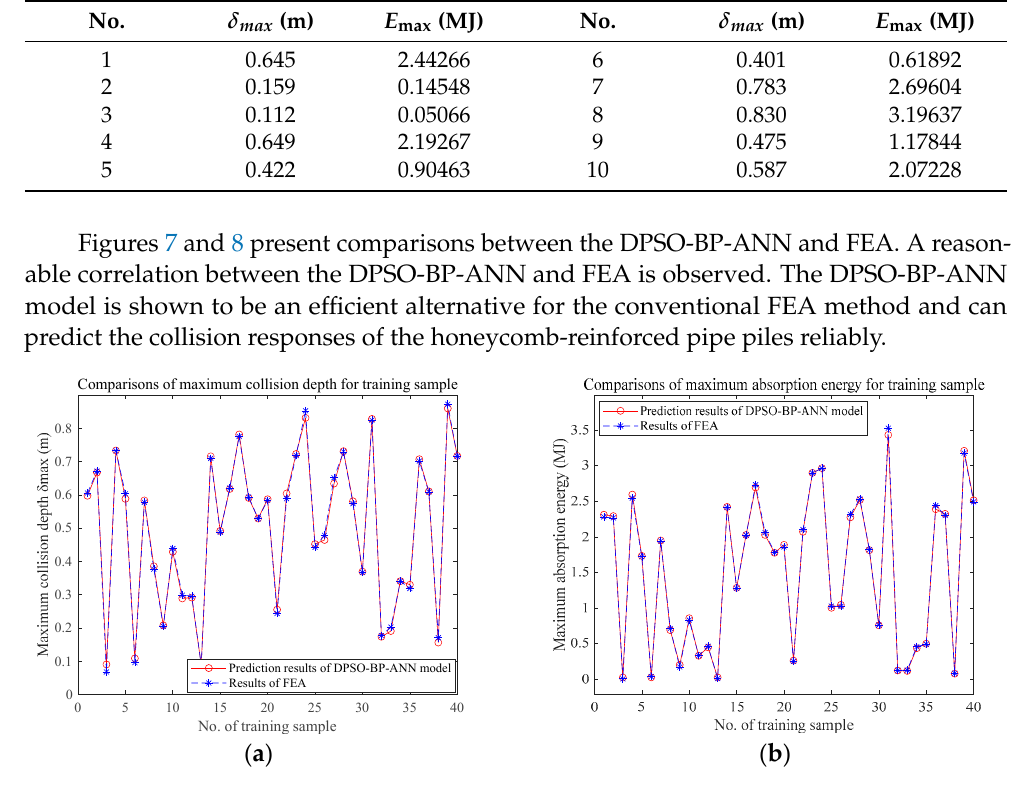
Table 8. Prediction results of DPSO-BP-ANN model for testing samples.